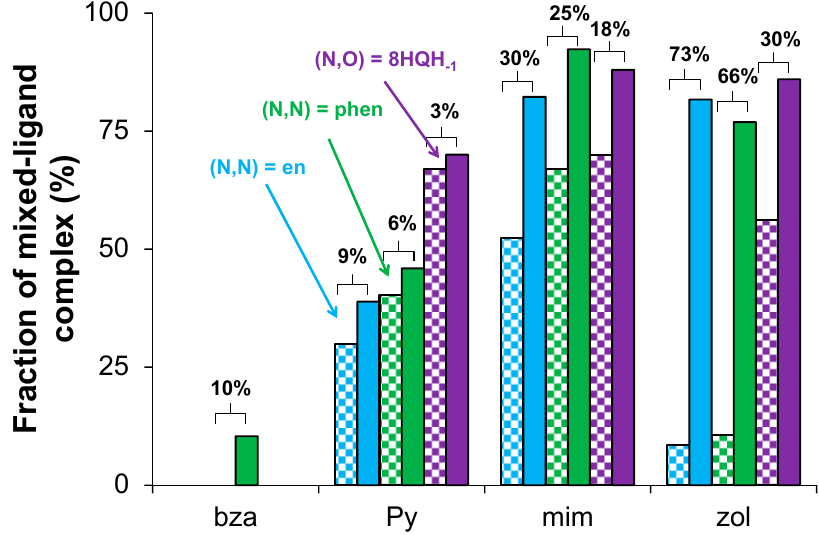
Figure 1. Fractions of the formed mixed‑ligand [RhCp*(N,N/O)(N)] 2+/+ complexes at c (complex): c (monodentate ligand) = 1:1 ratio measured at pH = 6.0 (full bars) and 7.4 (checkered bars). Fractions were determined by the integration of the peaks in the 1 H NMR spectra. The percentage values above the columns show the difference in the fractions of the mixed‑ligand complex at the two pH